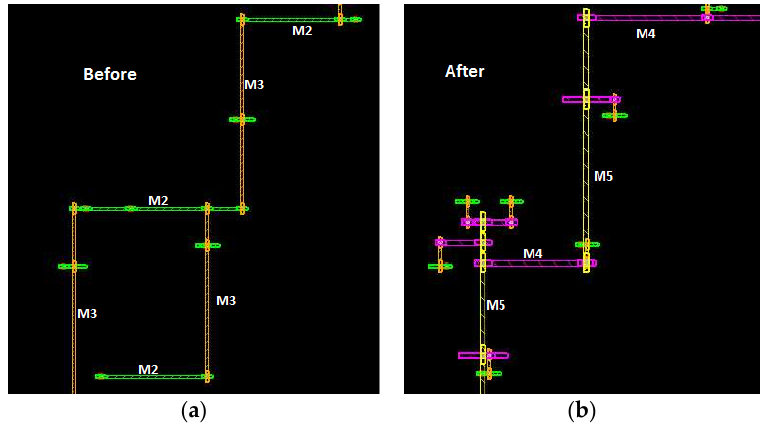
Figure 12. Net#2: detail wire used layers before ( a ) and after ( b ) optimization.